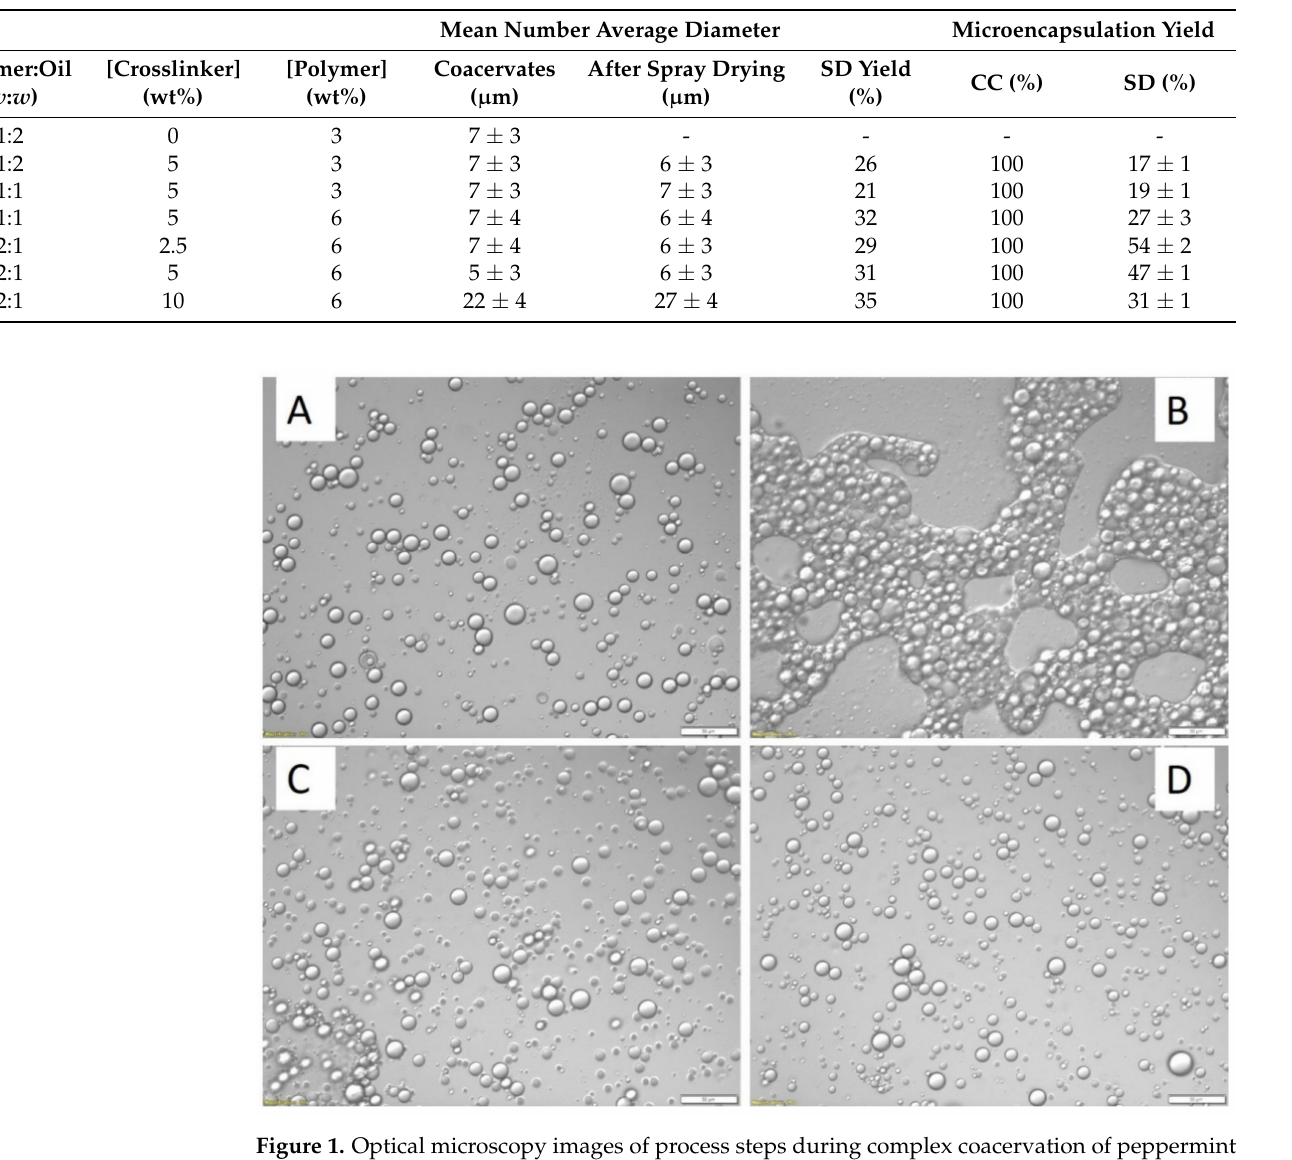
Figure 1. Optical microscopy images of process steps during complex coacervation of peppermint essential oil: oil-in-water emulsion at pH > 5 ( A ), coacervation at pH = 4.2 ( B ), crosslinking at pH 9 ( C ) and crosslinked capsules ( D ). The scale bar corresponds to 50 µ